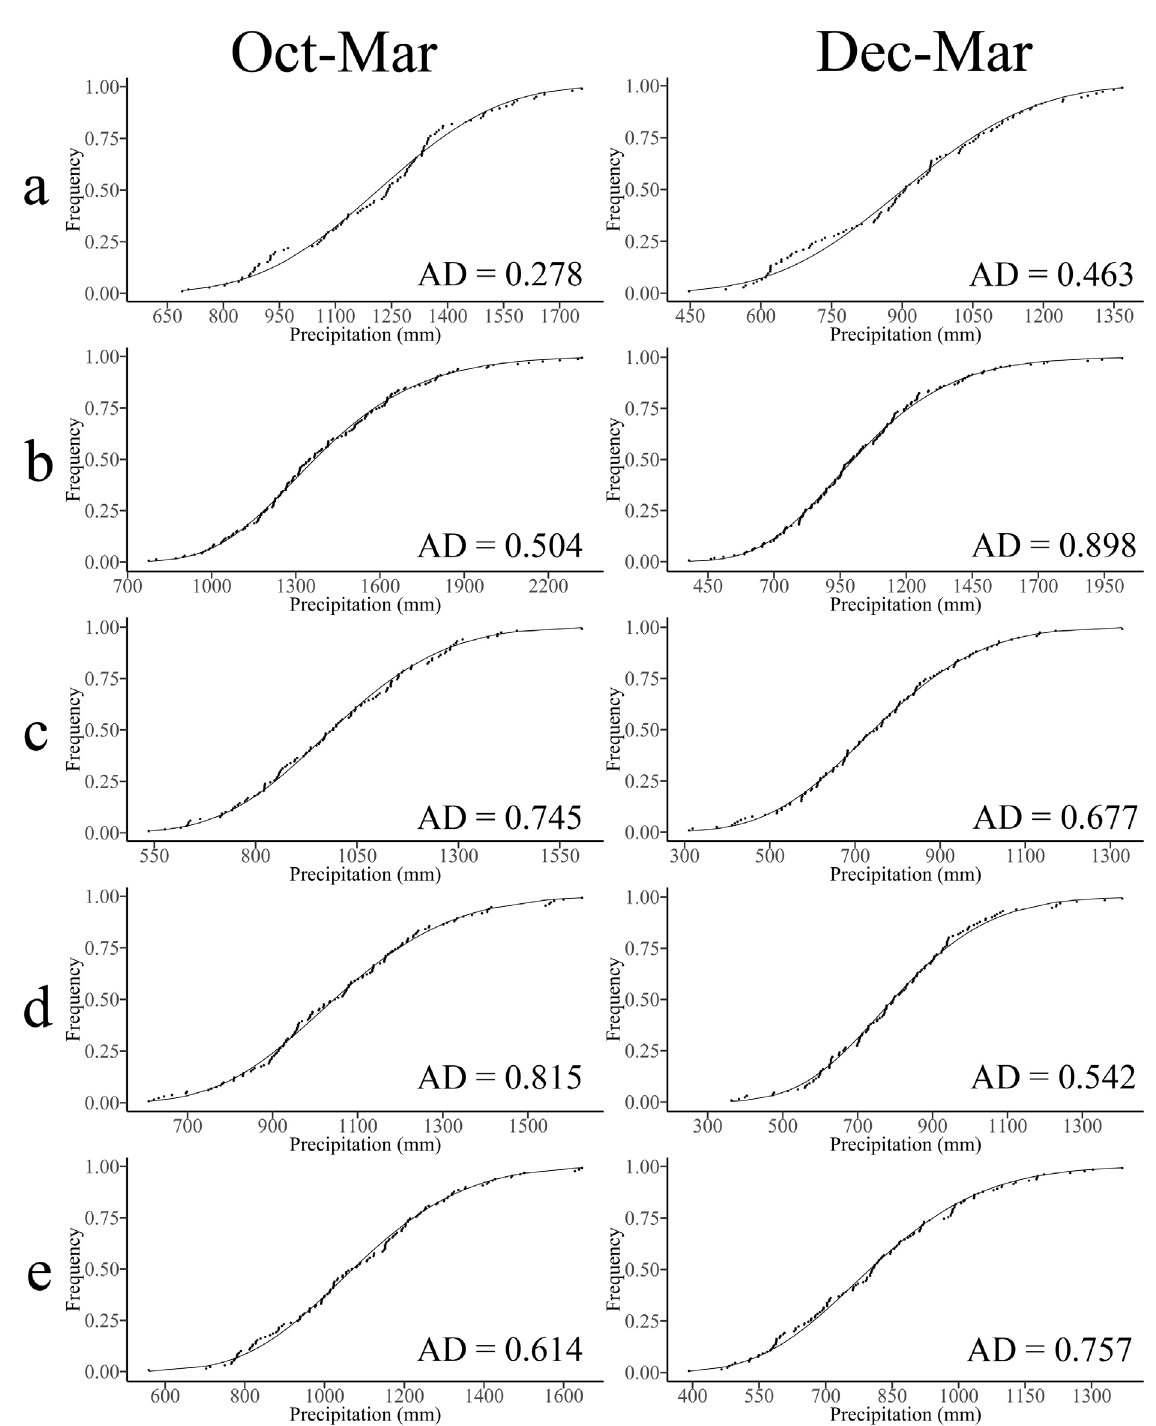
Figure 2. Goodness of the fit of the Gamma 2P PDF to the P6 and P4 precipitation historical series using Anderson- Darling test (a. South-MG; b. MR-BH; c. ME-SP; d. SP city; e.